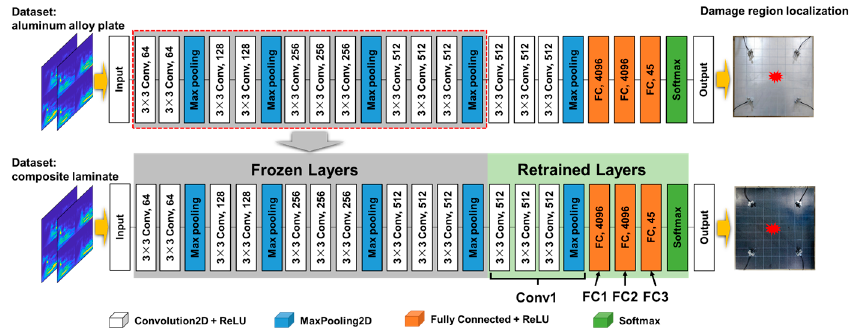
Figure 7. A transfer learning framework for locating damaged areas.